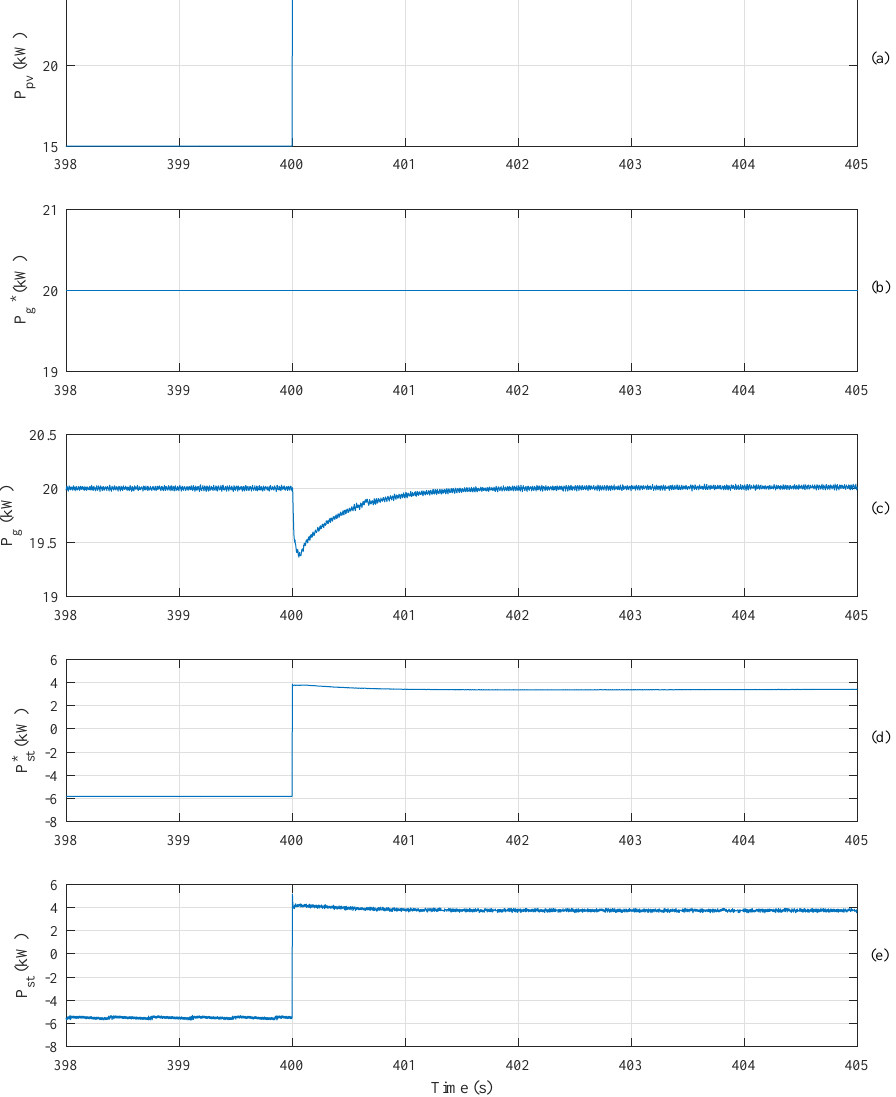
Figure 23. Results obtained for CPV 1 . Time responses of ( a ) power generated by the concentration photovoltaic (CPV) panel, p pv ; ( b ) reference of the grid power, p ∗ g ; ( c ) power injected into the grid, p g ; ( d ) reference of the hybrid energy storage system (HESS) power, p ∗ st ; and ( e ) power of the HESS, p st